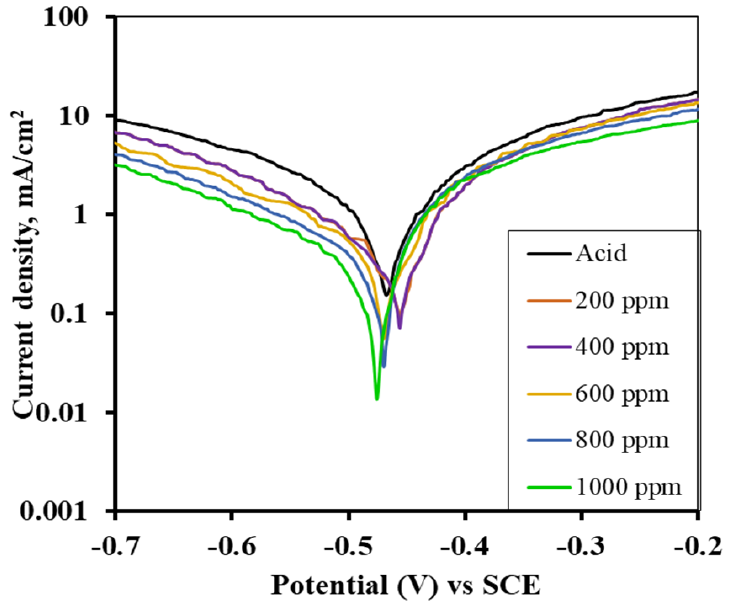
Figure 10. Potentiodynamic polarization curves for mild steel in 1 M H 2 SO 4 containing different concentrations of AV alkaloids as-immersed condition.